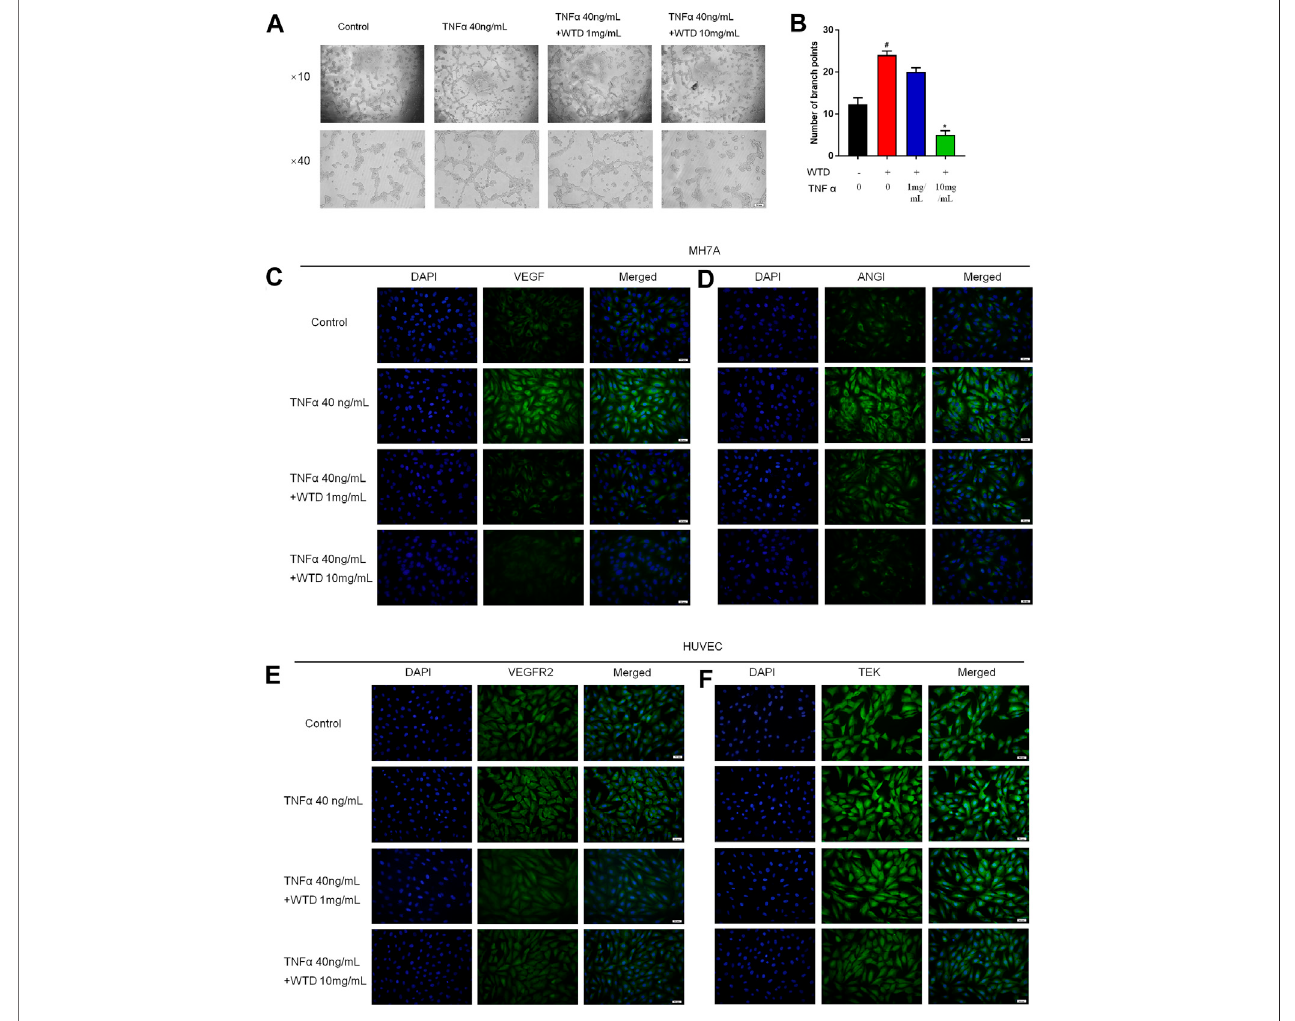
FIGURE 5 | The effects of WTD on the ability of MH7A cells to induce HUVEC angiogenesis. (A) Representative HUVEC tube formation sections after 6 h of cocultivation with MH7A cells (original magni fi cation, × 100 and × 400). (B) Quanti fi cation of the number of branch points for (A) . (C – D) Representative immuno fl uorescence staining for VEGF and ANGI in MH7A cell sections. Scale bar: 50 μ m. (E – F) Representative immuno fl uorescence staining for VEGFR2 and TEK in HUVEC sections. Scale bar: 50 μ m. The results are expressed as mean ± SE. All experimental results were repeated three times. # p < 0.05, ## p < 0.01versus the Control group; * p < 0.05, ** p < 0.01 versus the TNF α 40 ng/ml group.